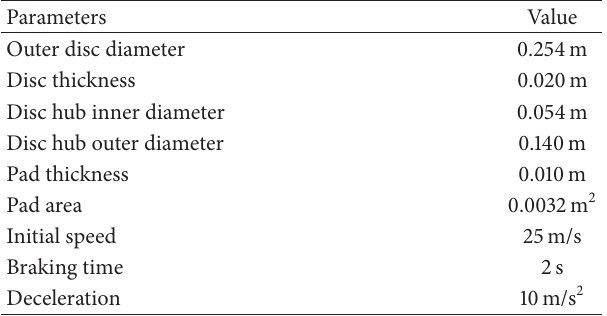
Table 2: Brake specifications and